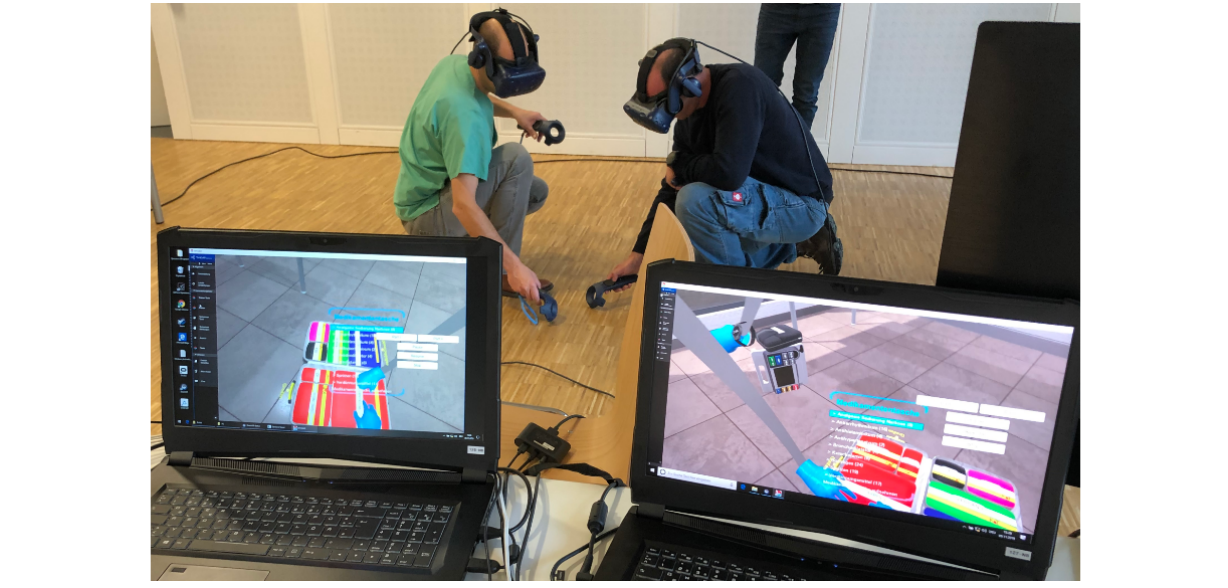
Figure 1. Two training participants equipped with virtual reality glasses and input